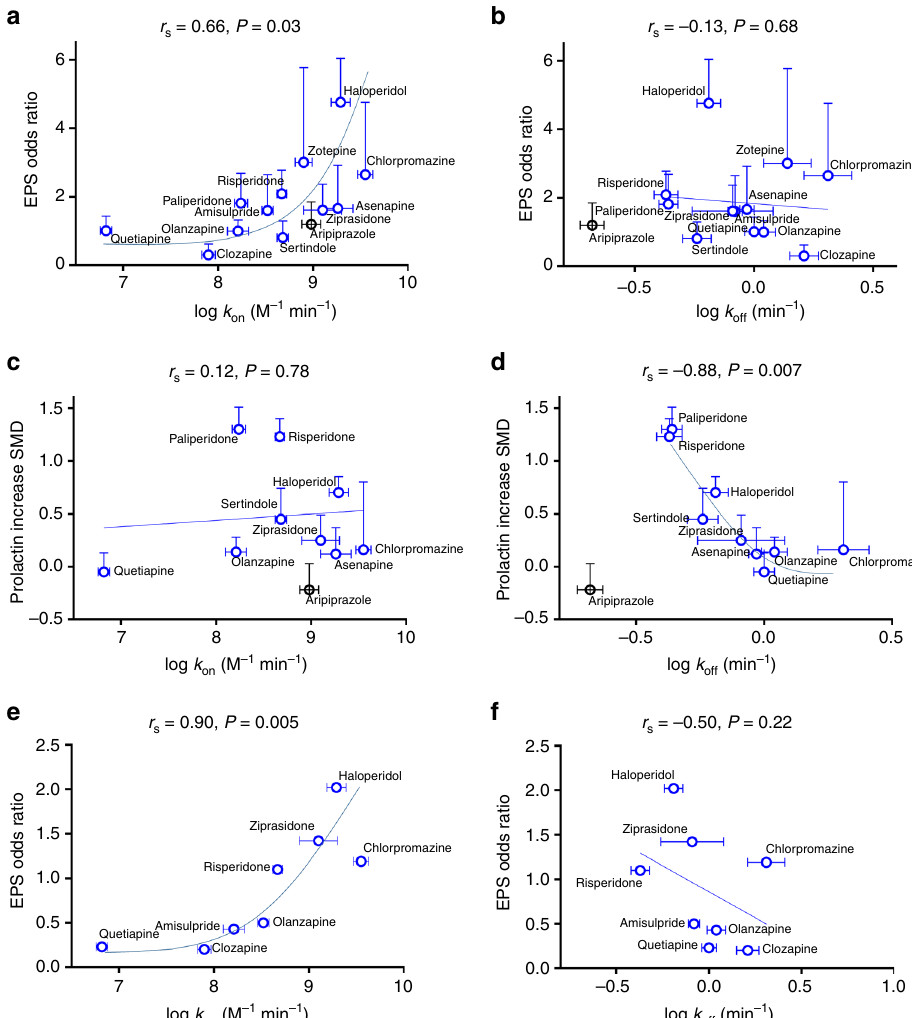
Fig. 3 Correlating clinical data on APD “ on-target ” effects with kinetically derived parameters. Correlation plots showing the relationship between a log k on and EPS odds ratio and b log k off and EPS odds ratio and c log k on and prolactin increase and d log k off and prolactin increase. All kinetic data used in these plots are detailed in Table 1 and clinical data are taken from Leucht et al. 31 . Kinetic data for aripiprazole were taken from Klein-Herenbrink et al. 21 . Aripiprazole was not included in the correlation analysis as it is a dopamine D 2 R partial agonist. Correlation plot showing the relationship between e log k on and EPS odds ratio and f log k off and EPS odds ratio, clinical data taken from fi rst-episode patient 50 – 57 . Kinetic data are presented as mean ± s.e.m. from four experiments and clinical data as standardized mean difference ( SMD ) for prolactin increase and odds ratio for EPS with associated credible intervals where indicated. The relationship between two variables was assessed using a two-tailed Spearman ’ s rank correlation allowing the calculation of the correlation coef fi cient, r s . A P value of 0.05 was used as the cutoff for statistical signi fi cance and relationships depicted as trend